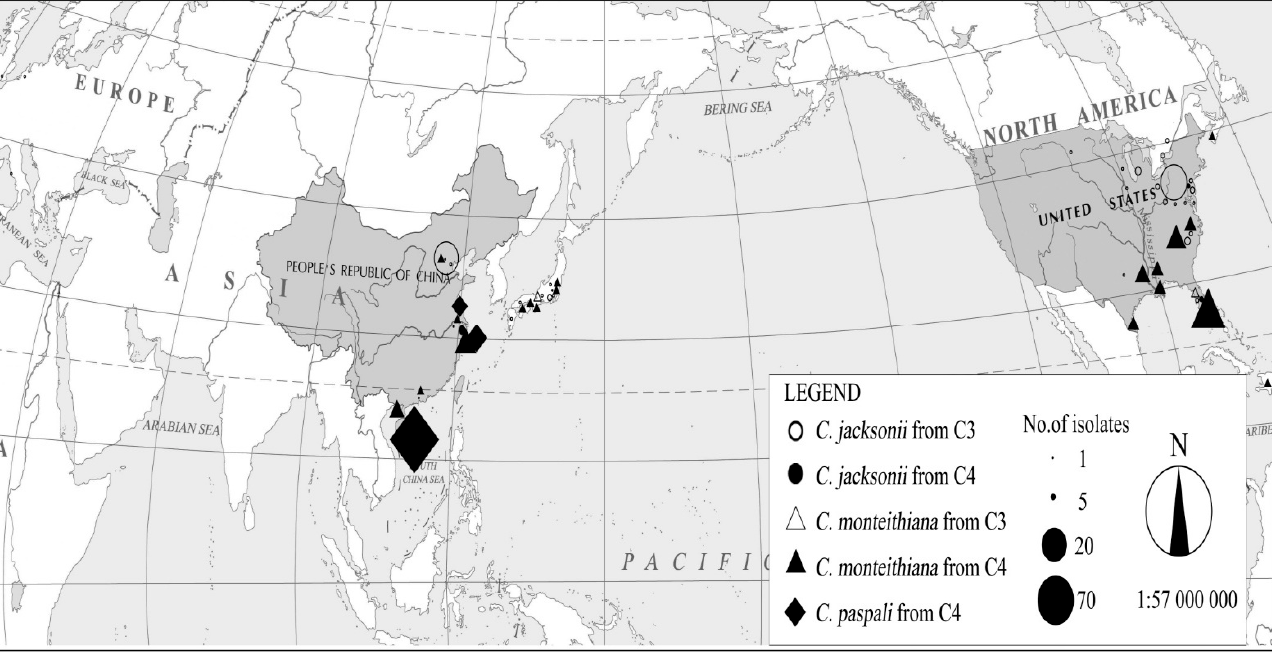
Table 2. Sensitivity profiles of the three Clarireedia species to thiophanate-methyl, propiconazole, iprodione, and boscalid. No. of Species